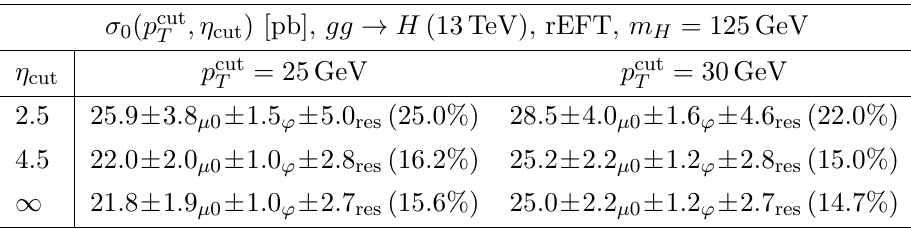
Table 1 . 0-jet cross section for gg p cut